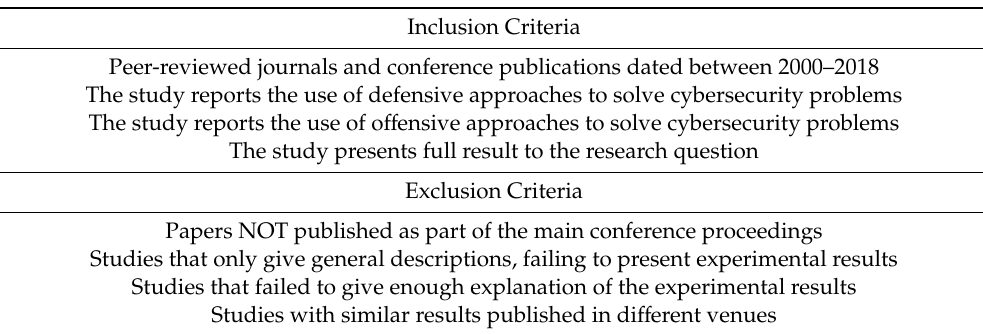
Table 1. Search inclusion and exclusion criteria.